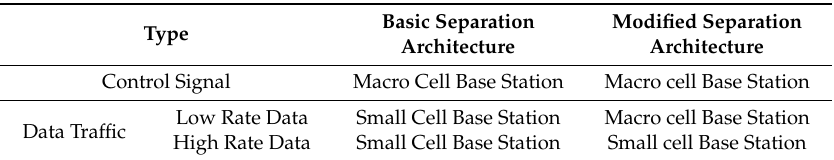
Table 1. Basic and modified separation architectures.